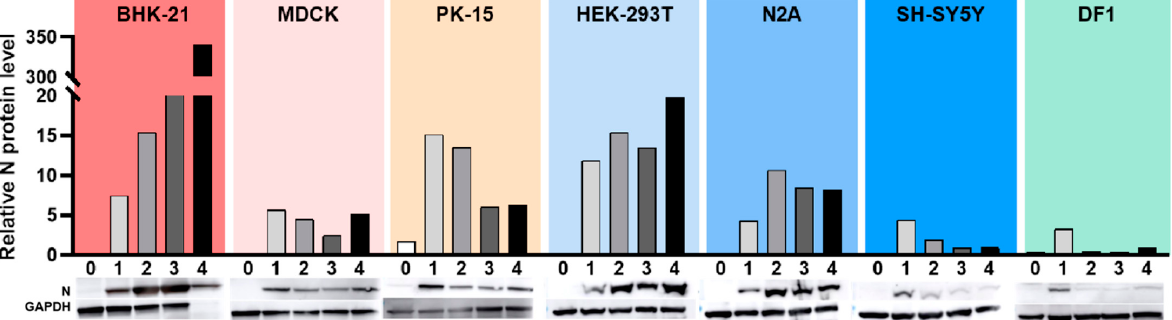
Figure 4. Detection of WUXV N protein in cells infected with SXWX1813-2. Cells infected with SXWX1813-2 at a multiplicity of infection (MOI) of 0.05 for 0d, 1d, 2d, 3d, 4d were lysed and analyzed by Western blot using the anti-N polyclonal antibody of WUXV. Protein expression was normalized to GAPDH. Densitometric values of protein bands were quantified by the Image J. Data were analyzed using GraphPad Prism™ software 8.0.2 (GraphPad Software, Inc., San Diego CA, USA).